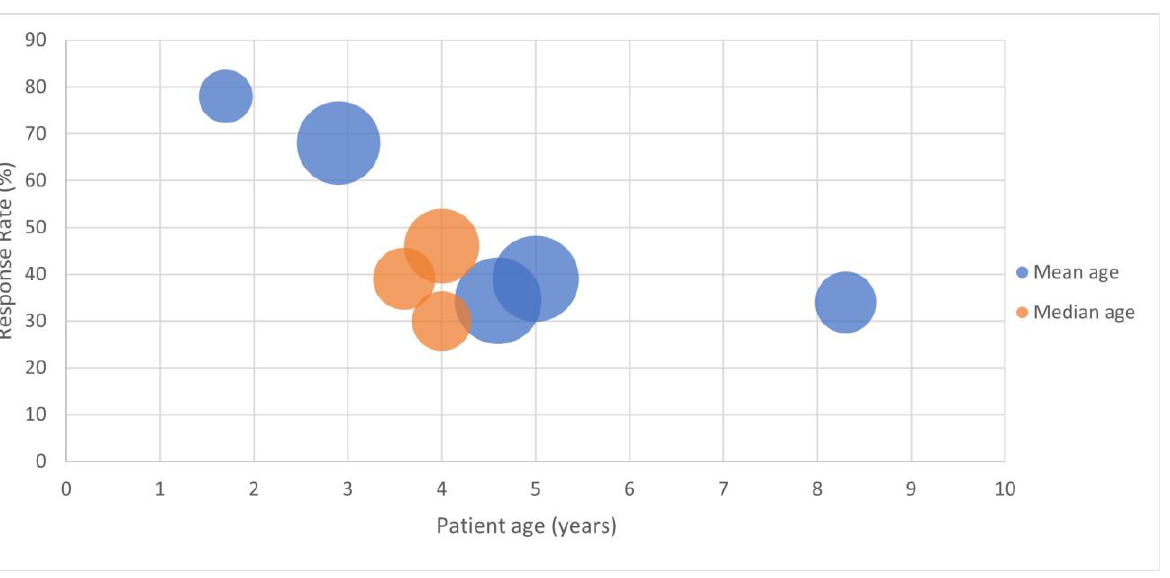
Table 2. Studies on investigations for detection of cows ’ milk allergy in which constipation was reported by some participants.